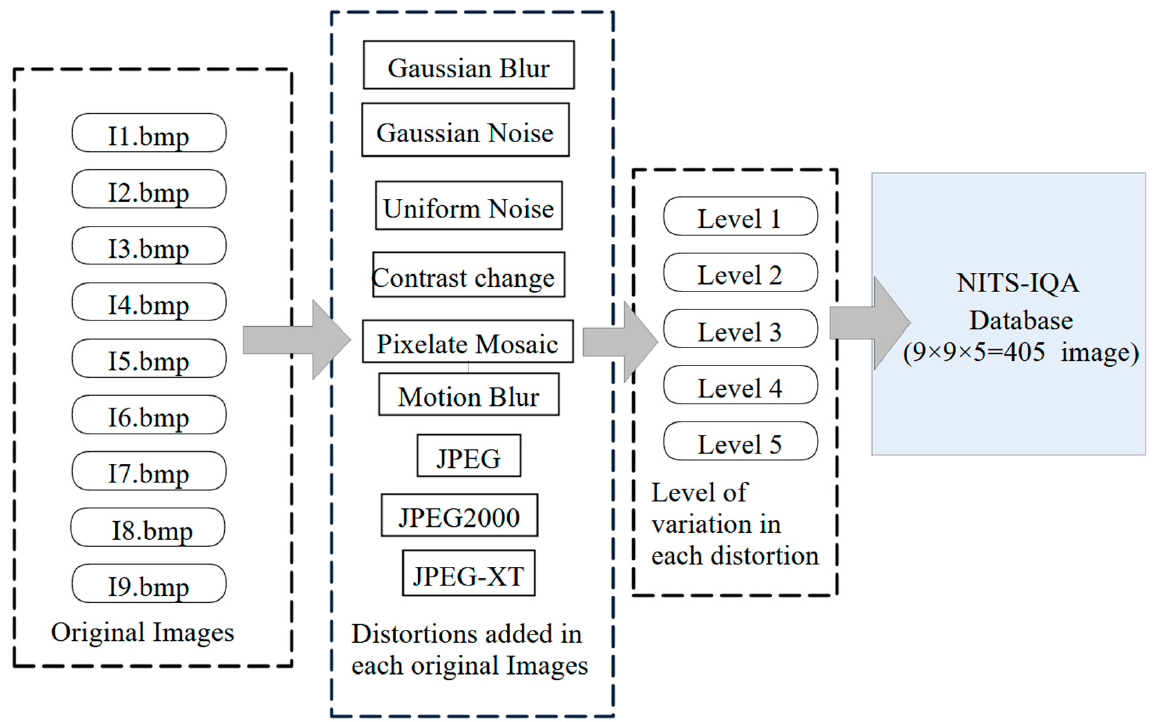
Figure 4. Development stages of NITS-IQA database.